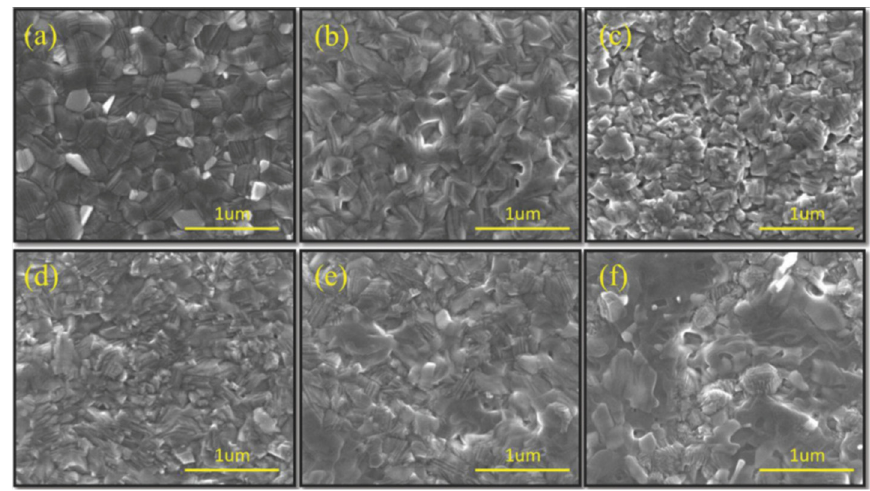
Figure 3. Top-view SEM images of ( a ) pristine perovskite film and ( b – f ) post-treated perovskite film with the increase ratio of iBAI. Republished with permission of John Wiley and Sons, from reference [27].